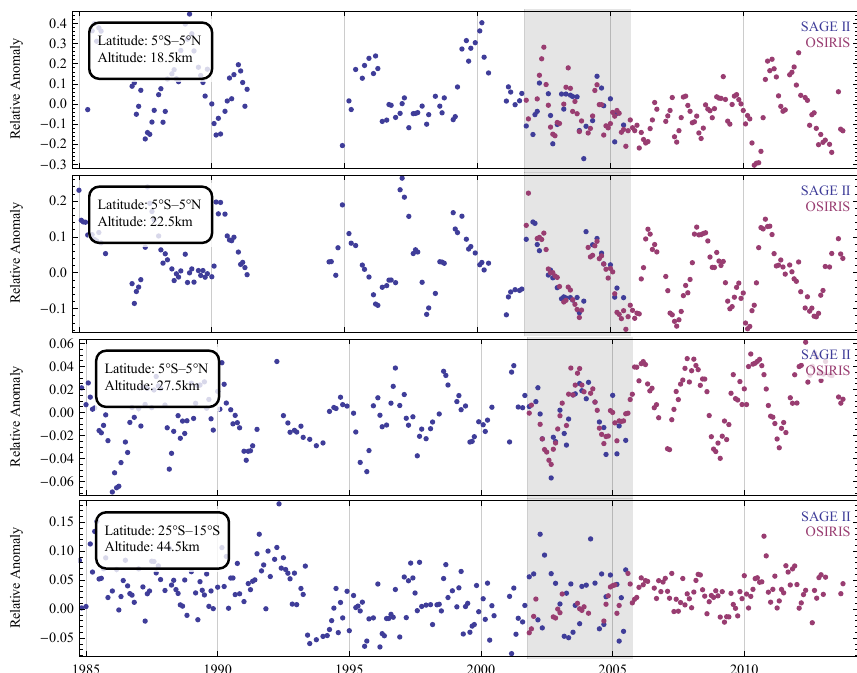
Figure 3. Deseasonalized ozone anomaly at the same locations as Fig. 1 calculated for each instrument independently. In the top panel, the strong seasonal cycle observed just above the tropical tropopause has been effectively removed. The remaining variability is mostly due to the QBO and tropopause pressure. At high altitudes in the tropical stratosphere, shown in the second and third panels, the QBO signal dominates the anomaly. For the upper stratosphere, shown in the bottom panel, the QBO signal has greatly